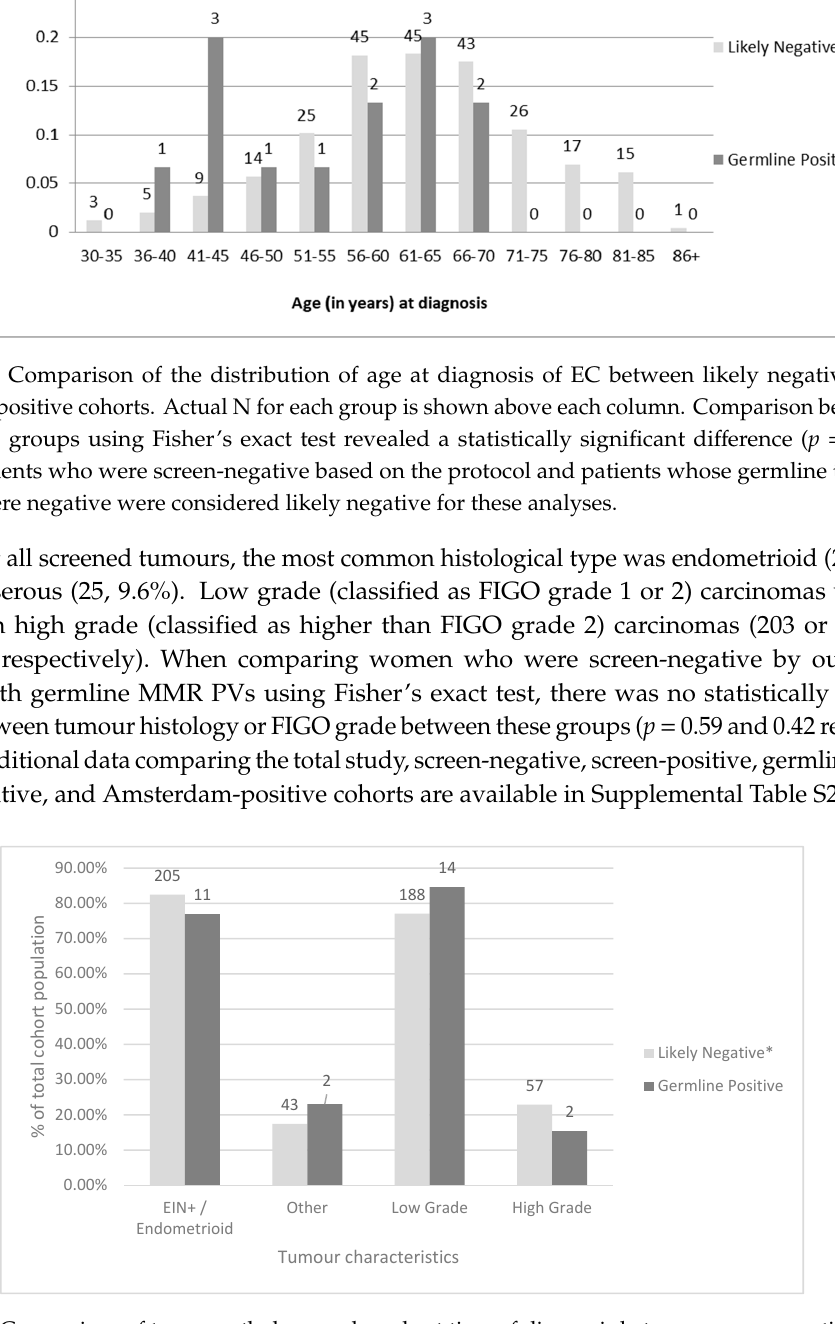
Figure 5. Comparison of tumor pathology and grade at time of diagnosis between screen-negative and germline-positive cohorts. EIN+ = EIN with pathological features bordering on early carcinoma. Actual N for each group is shown above each column. * Patients who were screen-negative based on the protocol and patients whose germline testing results were negative were considered likely negative for these analyses.